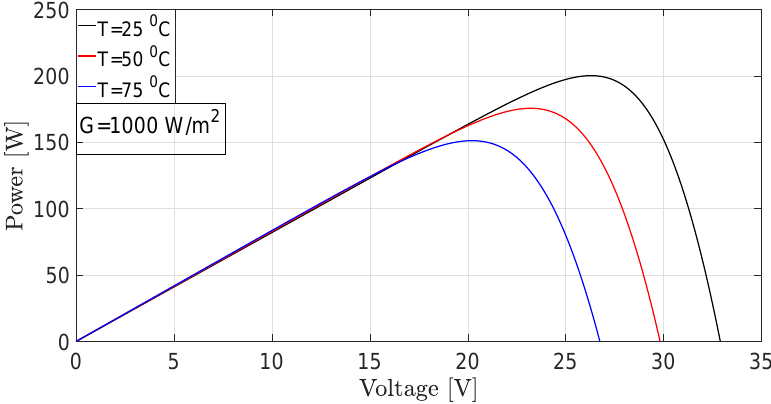
Figure 5. P–V characteristics of the PV source for various temperature